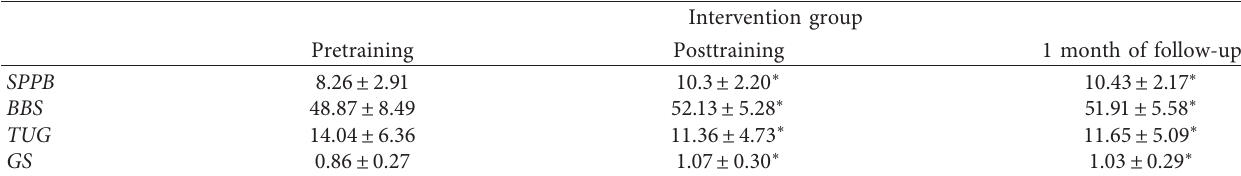
Table 2: Results of the short physical performance battery, Berg balance scale, timed up and go, and gait speed test obtained for the intervention group a